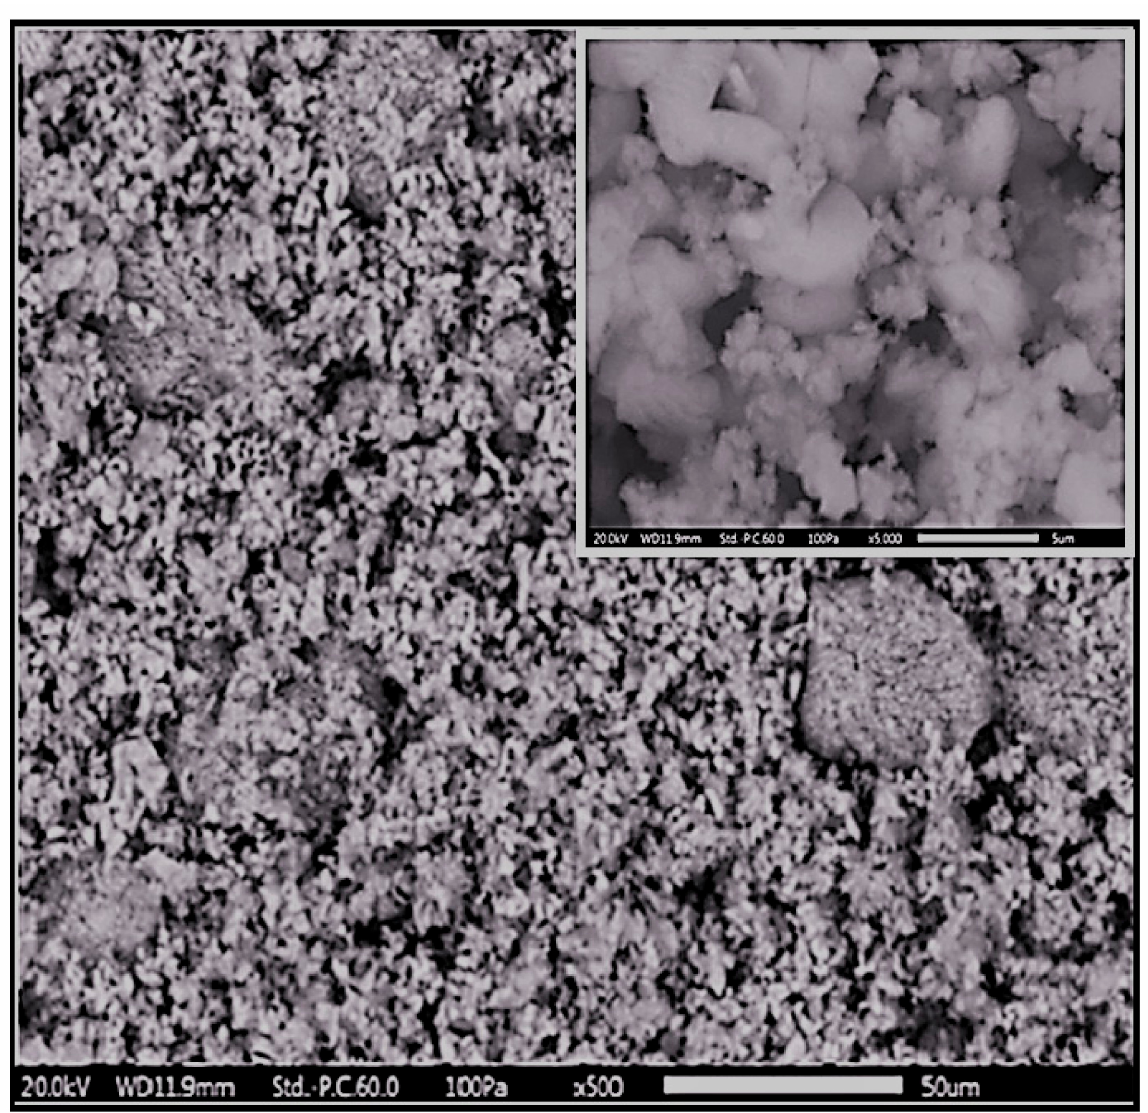
Figure 4. Calcium oxide on activated carbon (CaO/AC) as seen under a scanning electron